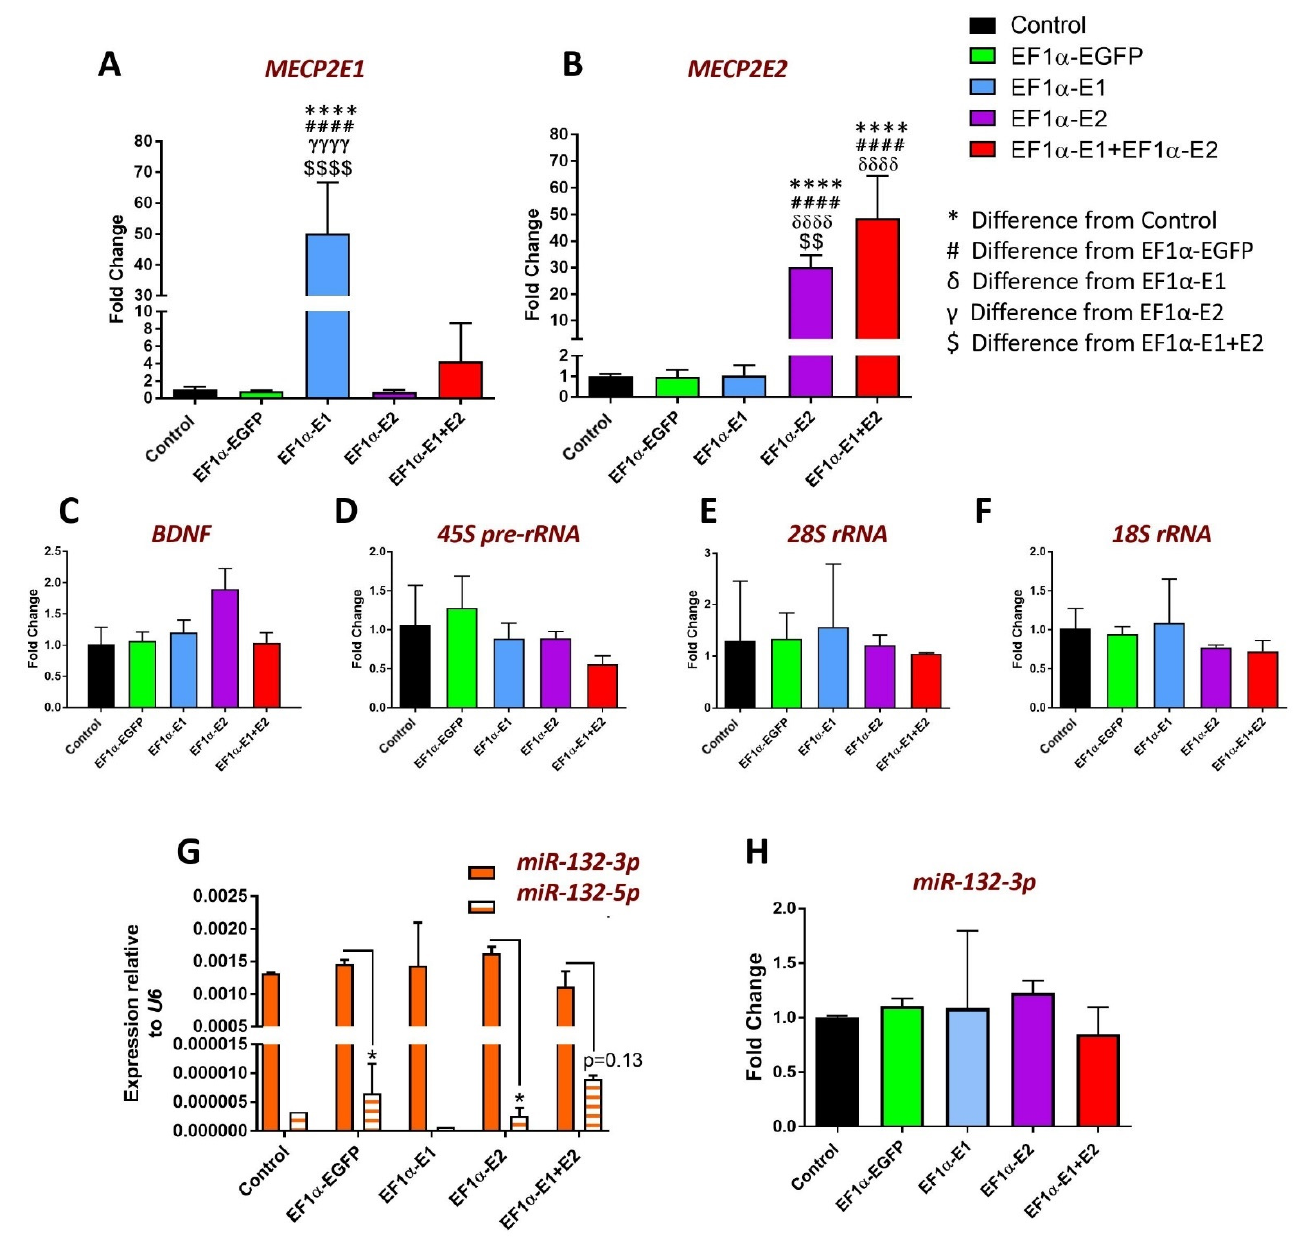
Figure 3. RT-PCR analysis of indicated transcripts in Daoy cells transduced with lentiviral vectors expressing MeCP2 isoforms. C T values for ( A ) MECP2E1 , ( B ) MECP2E2 , ( C ) BDNF , ( D ) 45S-pre-rRNA , ( E ) 28S rRNA , ( F ) 18S rRNA were normalized to the housekeeping gene GAPDH . Fold changes were determined relative to average non-transduced Daoy cell controls. Fold change values were analyzed by one-way ANOVA followed by Tukey’s multiple comparisons test. n = 5, and data are reported as mean ± SEM; *: p < 0.05, **: p < 0.01, and ****: p < 0.0001 (* indicates the difference from control; # indicates the difference from EF1 α -EGFP; δ indicates the difference from EF1 α -E1; γ indicates the difference from EF1 α -E2; $ indicates the difference from EF1 α -E1+E2, respectively). The p = 0.13 value in ( G ) is higher than the statistical significance of * p < 0.05. For ( G , H ), normalization has been carried out with U6 microRNA.